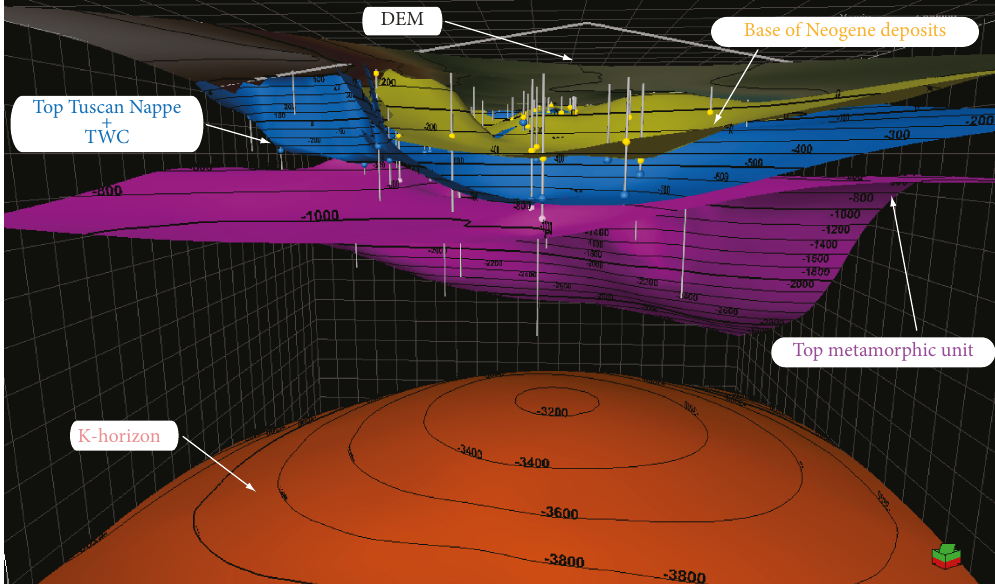
Figure 8: Stratigraphic surfaces modelled with Petrel (Schlumberger). Well data and geological maps have been used to constrain the surfaces at